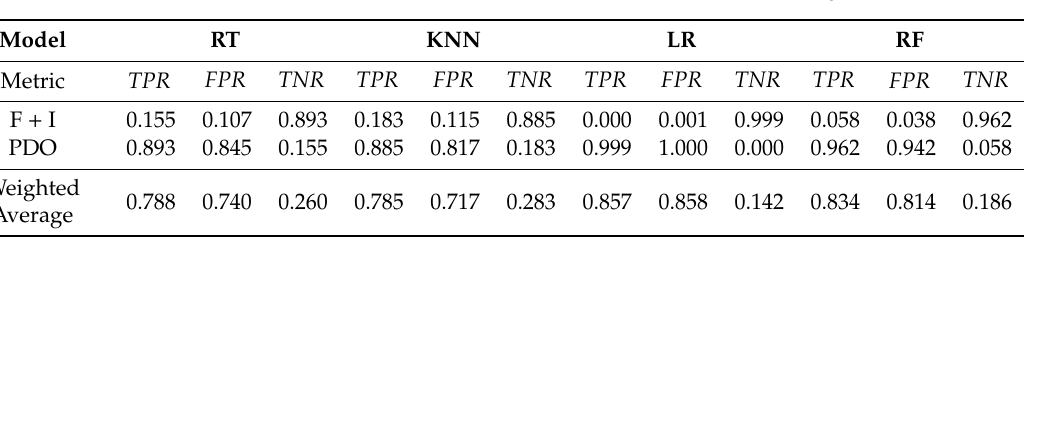
Table 9. Instances and percentages of the input factor “Day of the Week”.